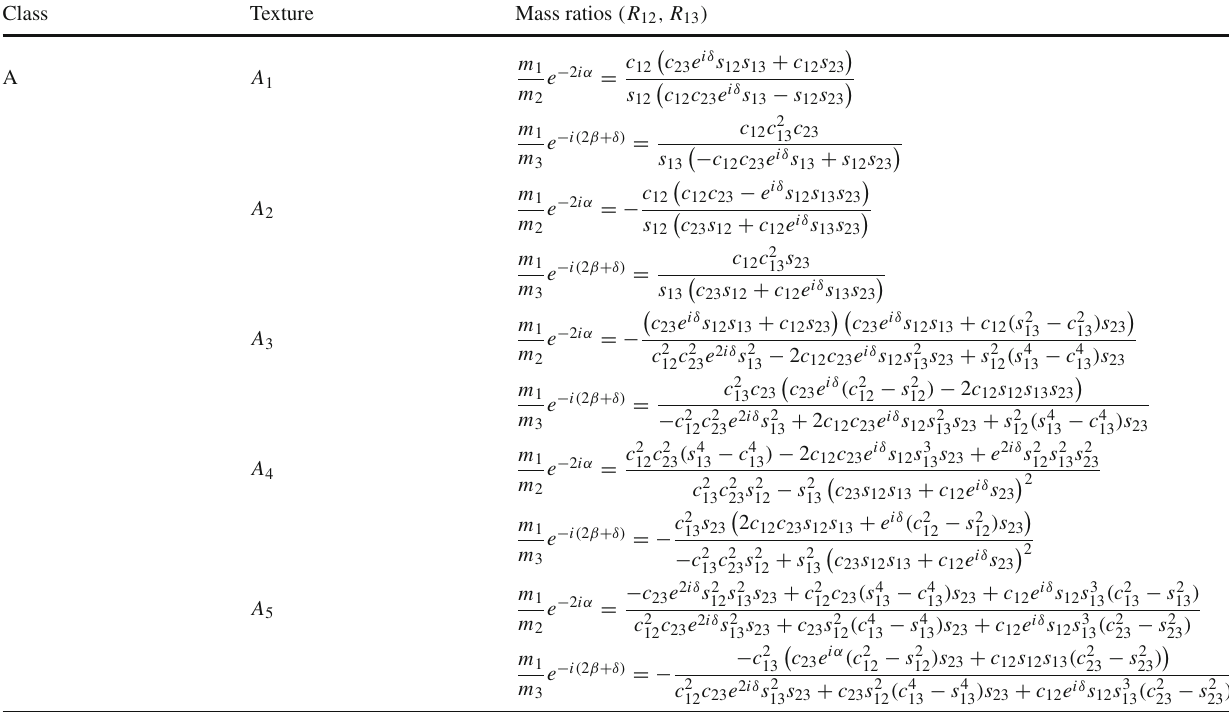
Table 2 Mass ratios for class A Class Texture Mass ratios ( R 12 , R 13